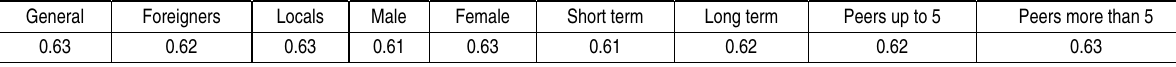
Table 1. General CPM index and indexes of all groups